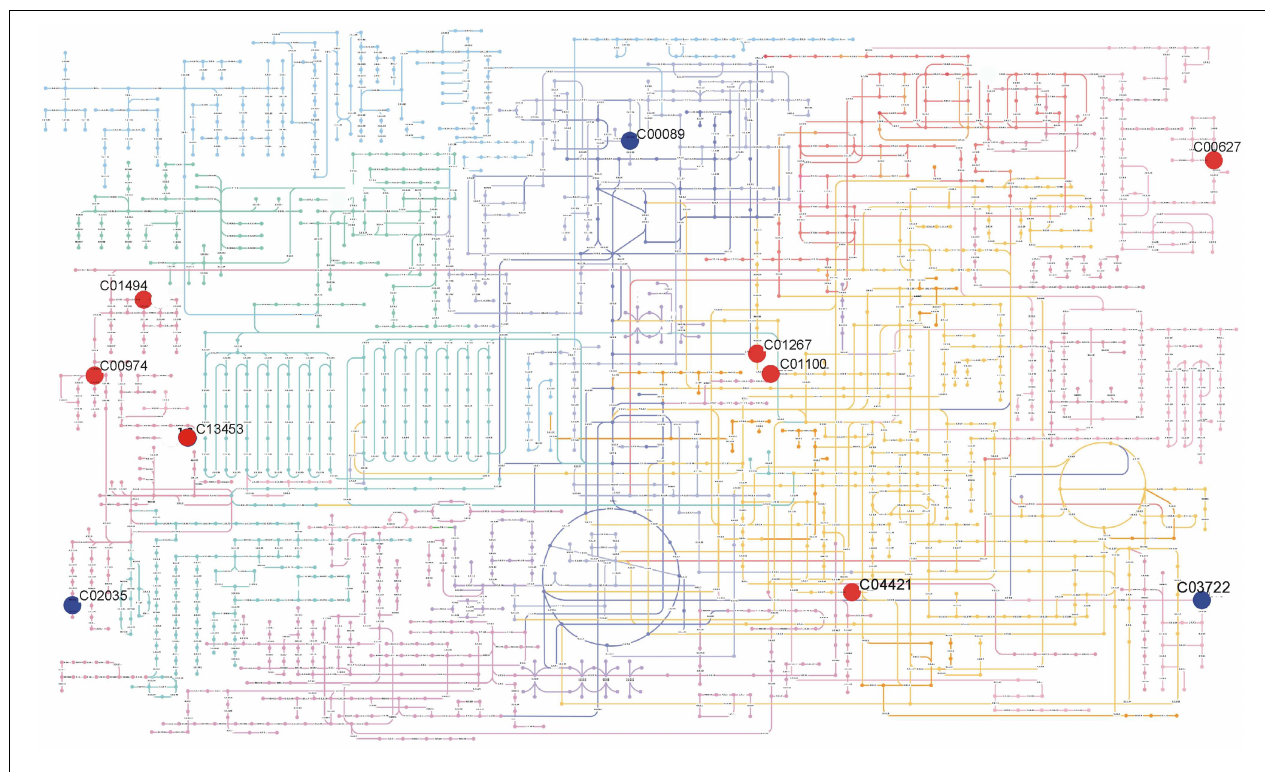
FIGURE 4 | Summary of metabolic differences detected in leaves of Col-0 and Ws-3 Arabidopsis thaliana accessions. The figure shows the metabolites present in KEGG Atlas with its KEGG ID: Ferulic acid (C01494); ( + )-Dihydrokaempferol (C00974); N-Succinyl-LL-2,6-diaminoheptanedioate (C04421); [5-Hydroxy-4-(hydroxymethyl)-6-methyl-3-pyridinyl]methyl dihydrogen phosphate (C00627); 3-(1H-Imidazol-4-yl)-2-oxopropyl dihydrogen phosphate (C01267); L-Histidinol phosphate (C01100);